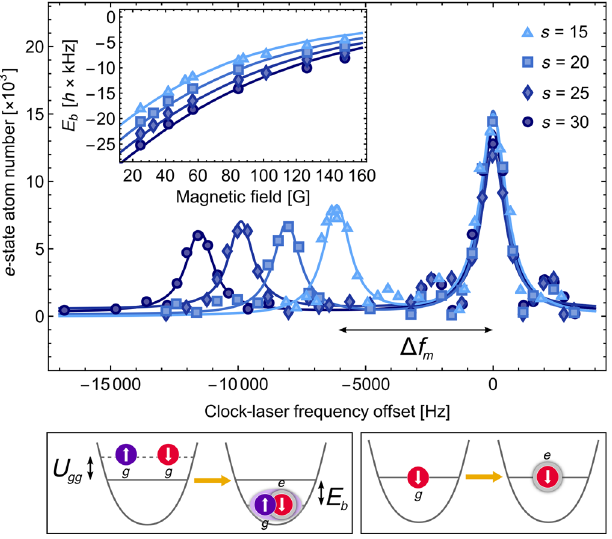
FIG. 3. Clock-laser spectroscopy of a m ¼ (cid:2) 5 = 2 sample of 173 Yb in a 3D lattice for different values of lattice depth and 150 G. The zero-frequency reference corresponds to the excita- tion of individual m ¼ − 5 = 2 atoms in singly occupied lattice sites, while the peaks at lower frequency correspond to the photoassociation process of j g i − j e i bound states. Inset: Value of the binding energy as a function of the magnetic field for different lattice depths, and the solid lines are a fit with the theoretical model (see text for